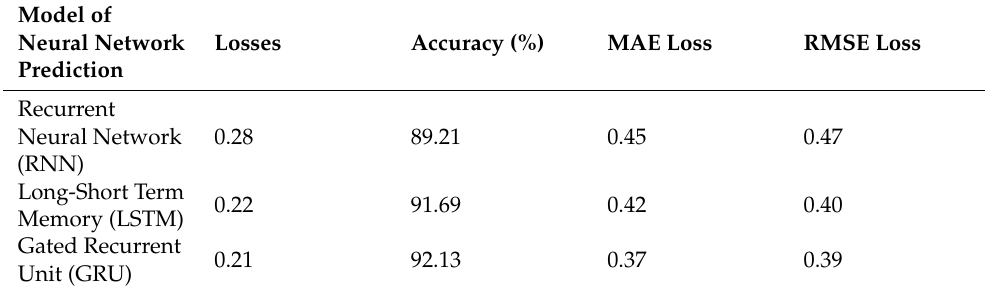
Table 6. Performance evaluation of various neural network models in terms of losses and